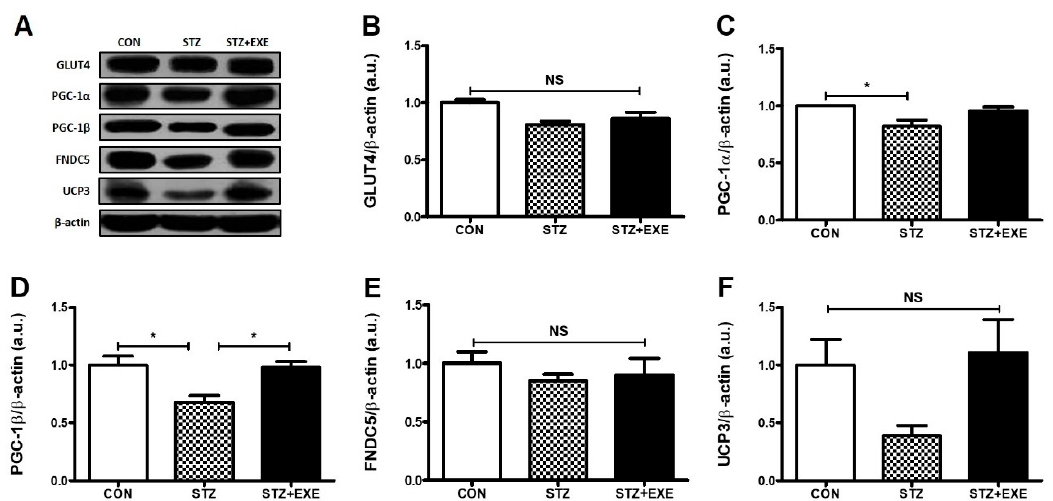
Figure 3. Aerobic exercise training increased PGC-1 β levels in the liver of type 1 diabetic rats. ( A ) Representative western blot. ( B ) Western blot analysis of liver GLUT-4 levels in type 1 diabetic rats, ( C ) Western blot analysis of liver PGC-1 α levels in type 1 diabetic rats ( D ) Western blot analysis of liver PGC-1 β levels in type 1 diabetic rats ( E ) Western blot analysis of liver FNDC5 levels in type 1 diabetic rats, ( F ) Western blot analysis of liver UCP3 levels in type 1 diabetic rats. Results are expressed the mean ± SE. * p < 0.5; NS, not significant.